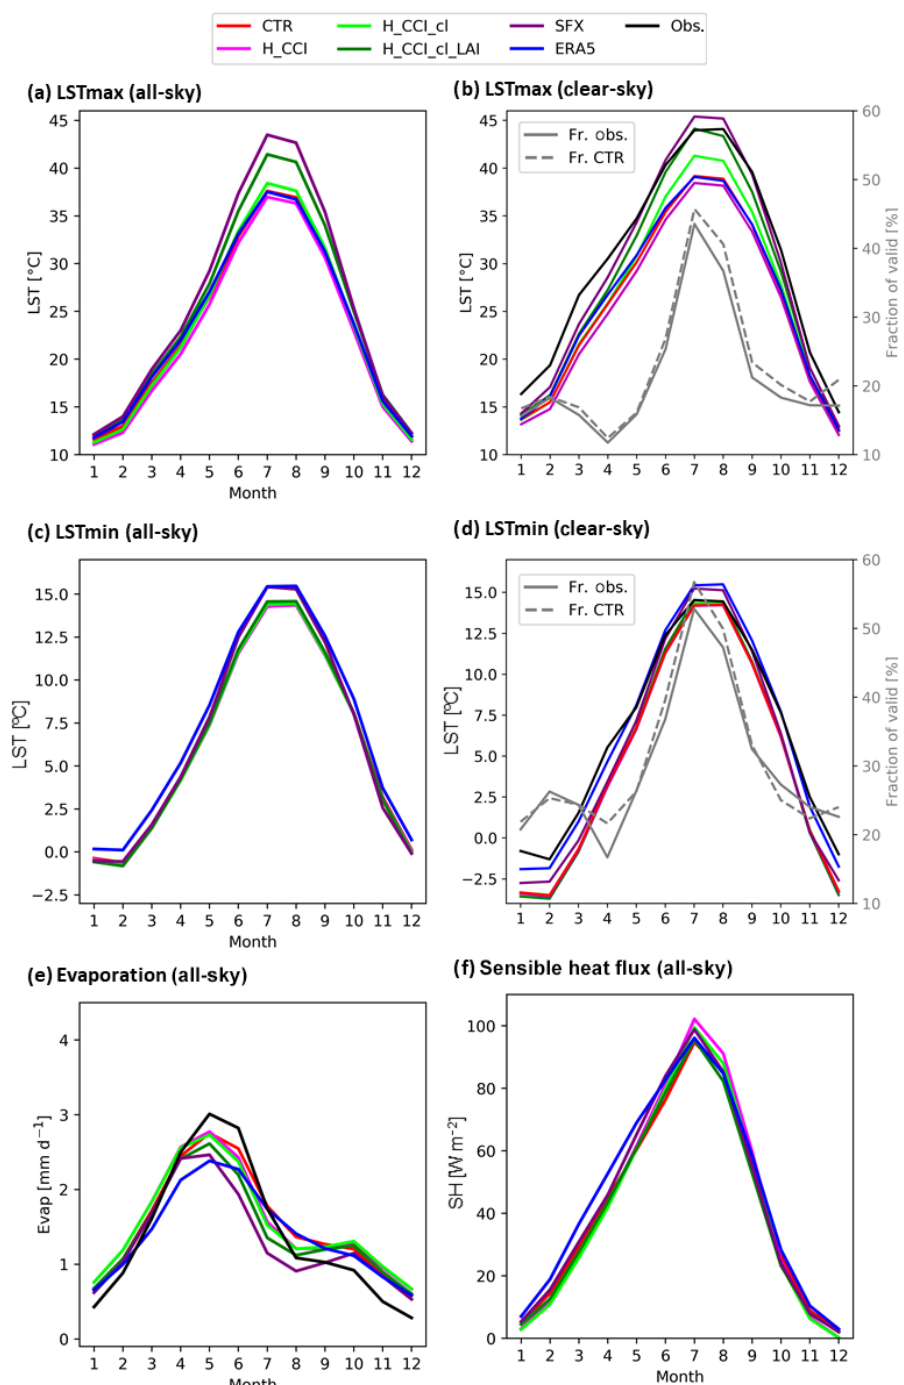
Figure 8. Seasonal cycles of daily maximum LST (a) under all-sky and (b) clear-sky conditions; daily minimum LST under (c) all-sky and (d) clear-sky conditions; (e) daily total evaporation under all-sky conditions and (f) daily mean sensible heat flux under all-sky conditions. All panels represent averages taken over all Iberia grid points considering all-sky conditions, for each month during the 2004–2015 period. Observations are available for LST under clear-sky conditions (LSA-SAF, black lines in panels b and d ) and for evaporation (GLEAM dataset, black line in panel c ). The gray lines in panels (b) and (d) represent the fraction of valid data points used to compute the clear-sky averages for LSA-SAF (full line) and model simulations (dashed), with the scale given by the y axis on the righthand